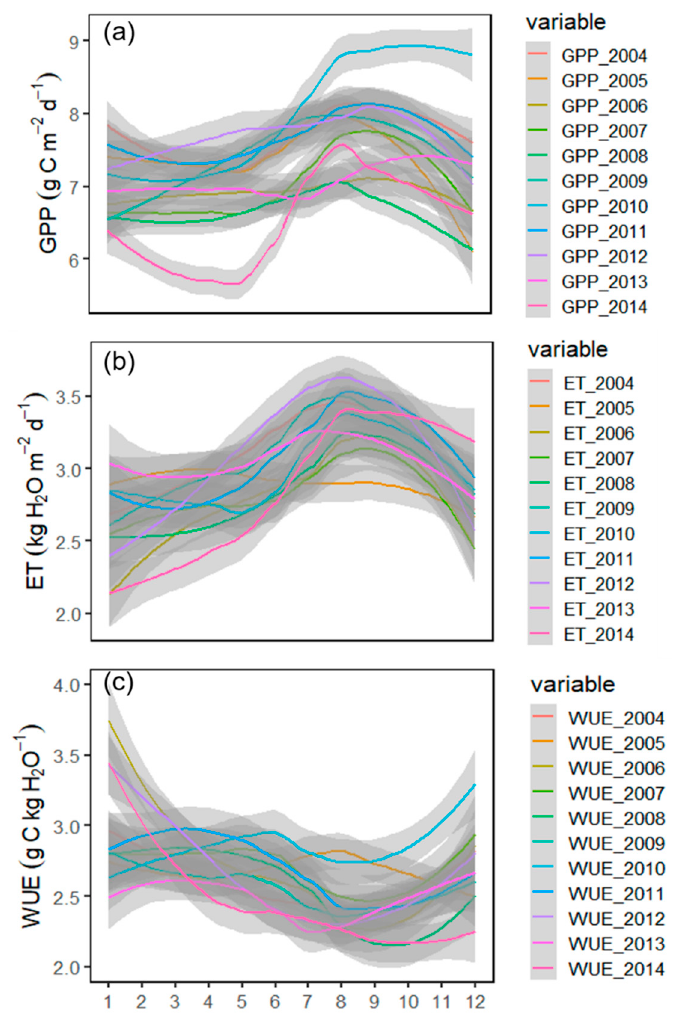
Figure 4. Seasonal variations (monthly means) in ( a ) ecosystem gross primary production (GPP), ( b ) ecosystem evapotranspiration (ET), and ( c ) ecosystem water use efficiency (WUE) based on daily smoothened values for each year from 2004–2014. Different colors were assigned for each year. Gray-shaded regions are the confidence intervals and the colored line in the grayscale line is the smooth curve. The two vertical broken lines in each panel represent the average day of the year for the beginning and end of the water depletion (WD) period. GPP data are from [25].